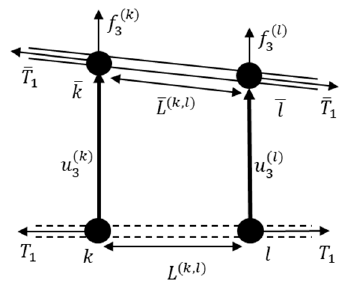
Figure 2. Deformation behavior of the